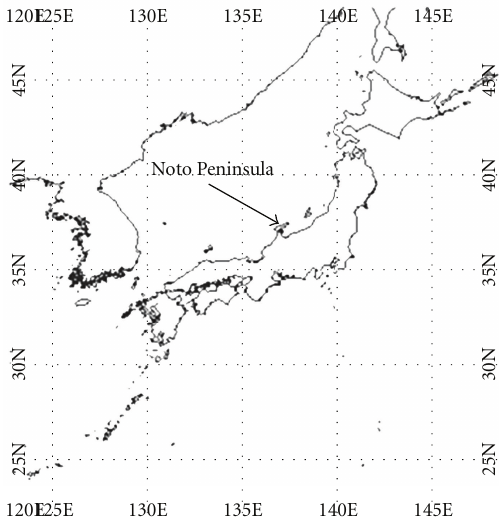
Figure 1: Location of Noto